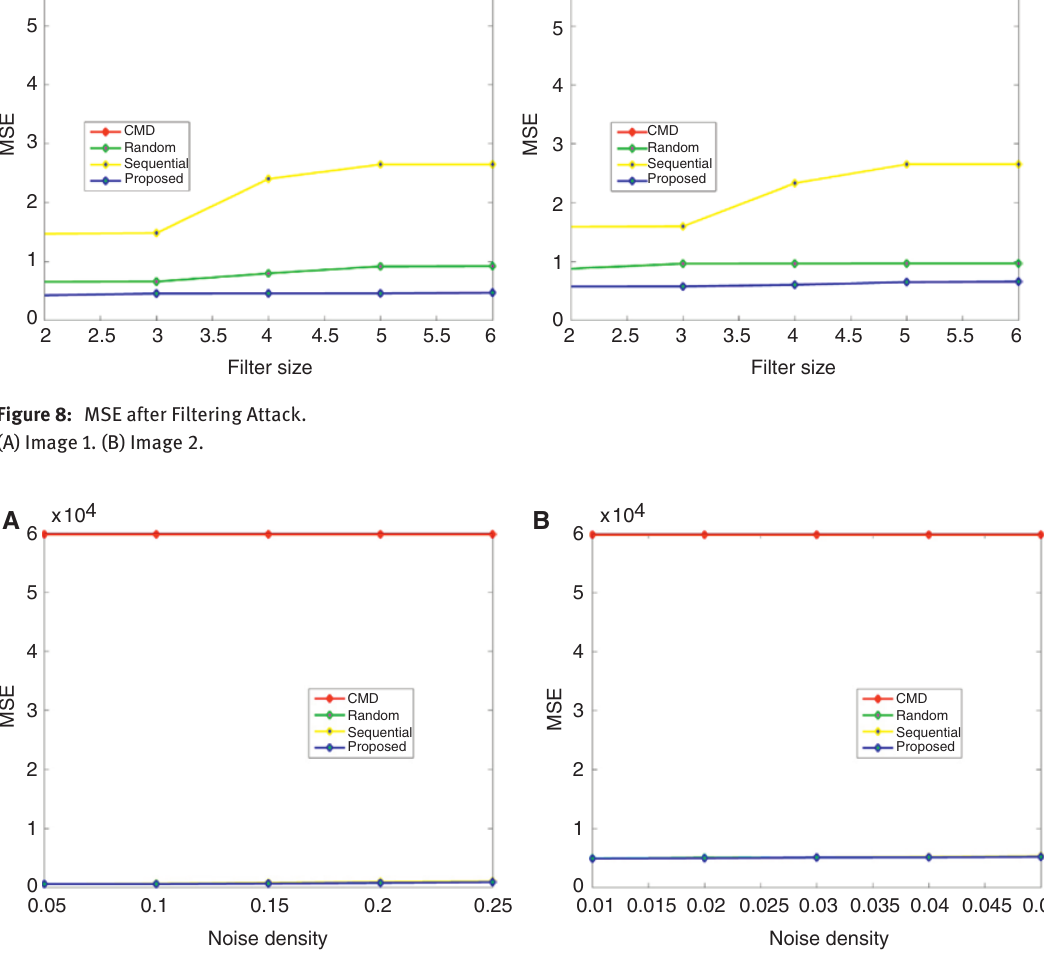
Figure 9: MSE after Noise